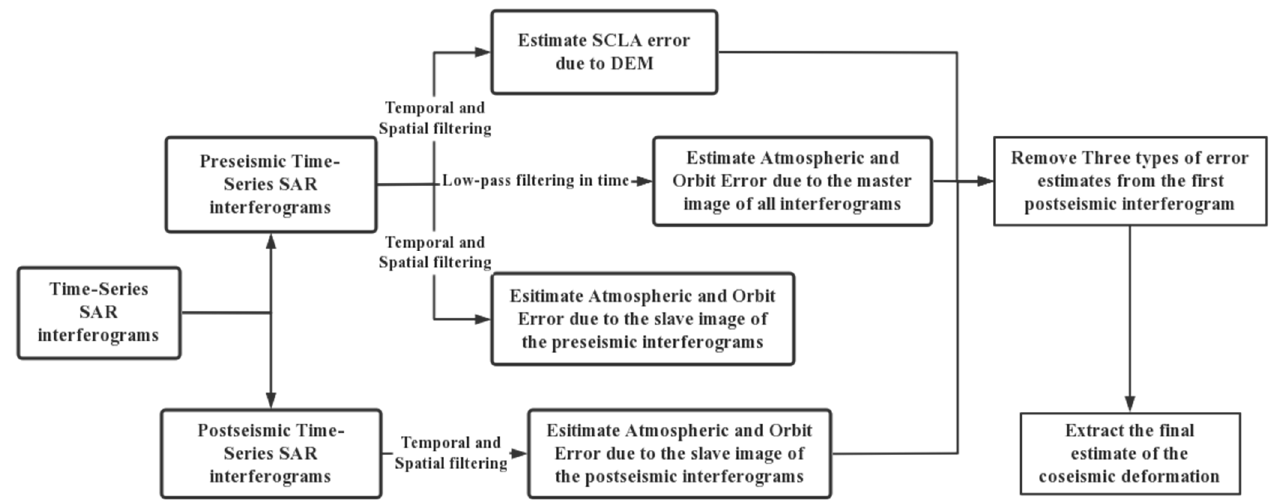
Figure 2. Time-series InSAR processing flow for coseismic deformation extraction.